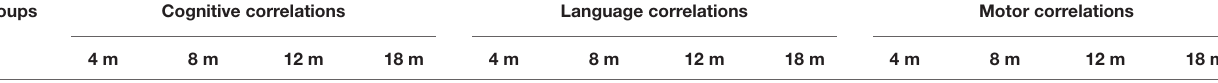
TABLE 4 | Neurodevelopment correlations within each neurodevelopment domain in each age.